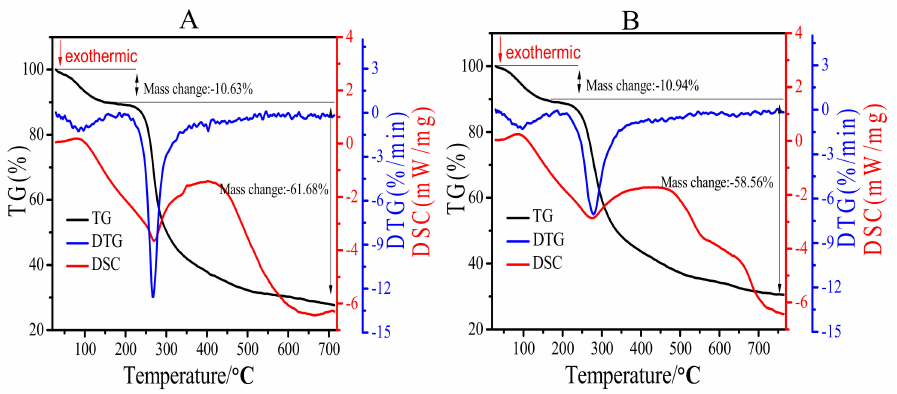
Figure 2. TG, DTG and DSC curves of Artp1 ( A ) and Artp2 ( B ).